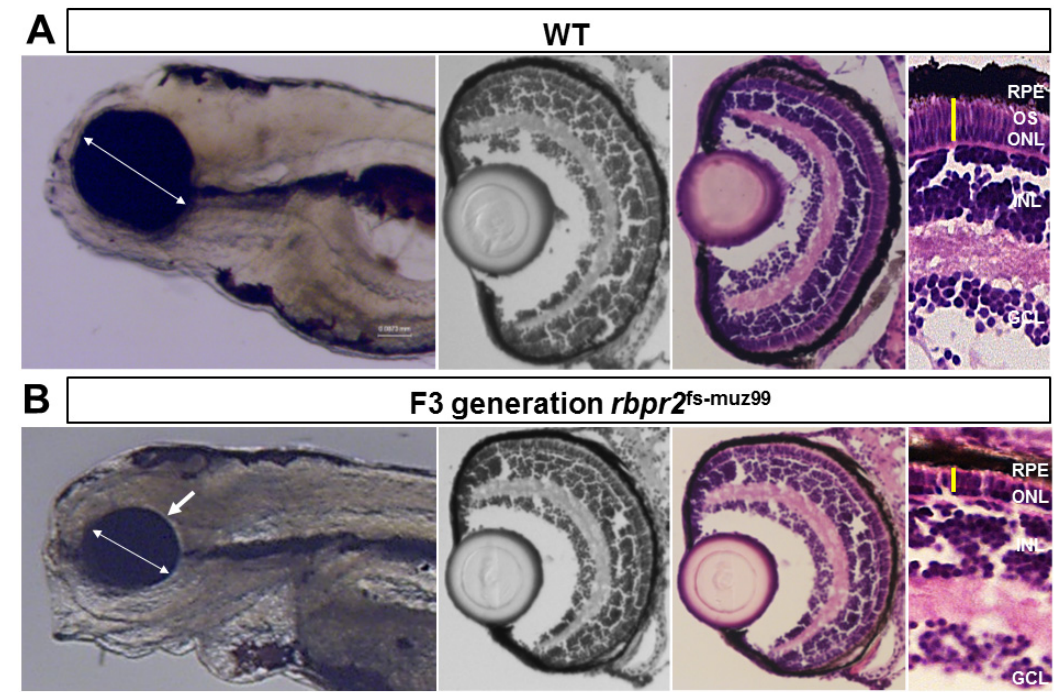
Figure 5. Rbpr2 mutants affecting the putative RBP4 binding domain show retinal phenotypes. ( A , B ) Cross-sections through the eyes of 5.5 dpf WT-Tg:T α C-GFP control ( A ) and F3 generation rbpr2: Tg:T α C-GFP homozygous mutant ( B ) larvae. The rbpr2 mutant eye is smaller (arrow) and shows shorter photoreceptor layer. RPE, retinal pigment epithelium; ONL, outer nuclear layer; INL, inner